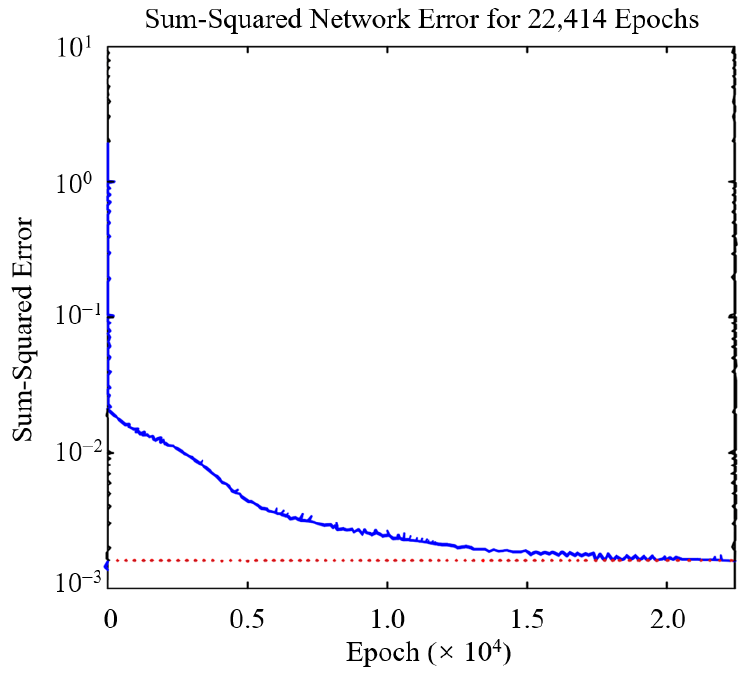
Figure 6. Error curve in training process.